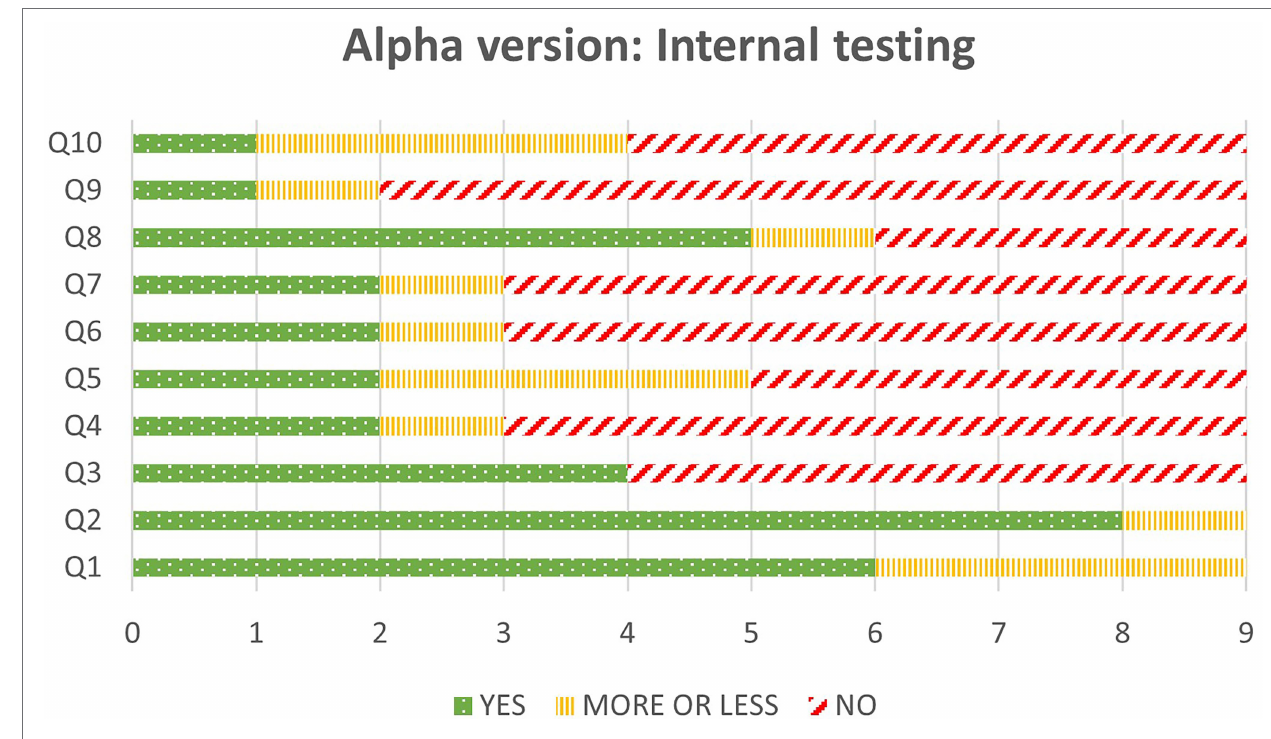
FIGURE 12 | Final value for questions in the internal